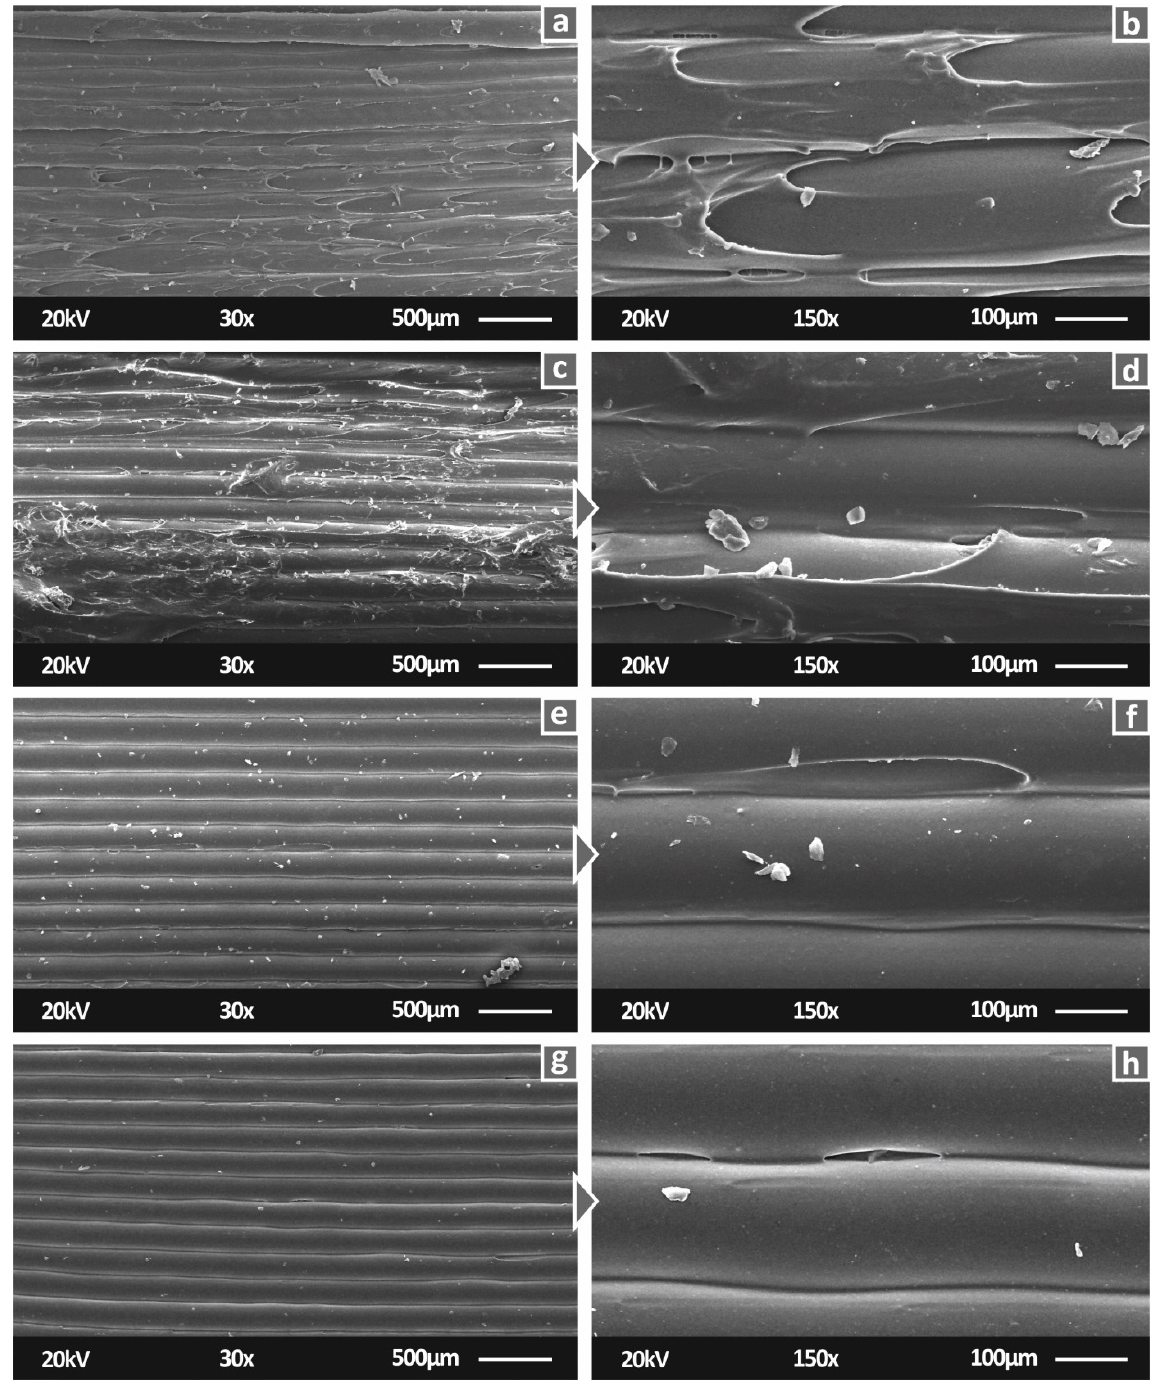
Figure 8. SEM 30× magnification side surface images for: ( a ) PA12/AgDANP 1.0 wt.%; ( c ) PA12/Ag- SEM 30 × magnification side surface images for: ( a ) PA12/AgDANP 1.0 wt.%; DANP 2.0 wt.%; ( e ) PA12/AgDANP 3.0 wt.%; ( g ) PA12/AgDANP 4.0 wt.%, 150× magnification of ( c ) PA12/AgDANP 2.0 wt.%; ( e ) PA12/AgDANP 3.0 wt.%; ( g ) PA12/AgDANP 4.0 wt.%, 150 × side surface for ( b ) PA12/AgDANP 1.0 wt.%; ( d ) PA12/AgDANP 2.0 wt.%; ( f ) PA12/AgDANP 3.0 magnification of side surface for ( b ) PA12/AgDANP 1.0 wt.%; ( d ) PA12/AgDANP 2.0 wt.%; wt.%; ( h ) PA12/AgDANP 4.0 wt.%. ( f ) PA12/AgDANP 3.0 wt.%; ( h ) PA12/AgDANP 4.0